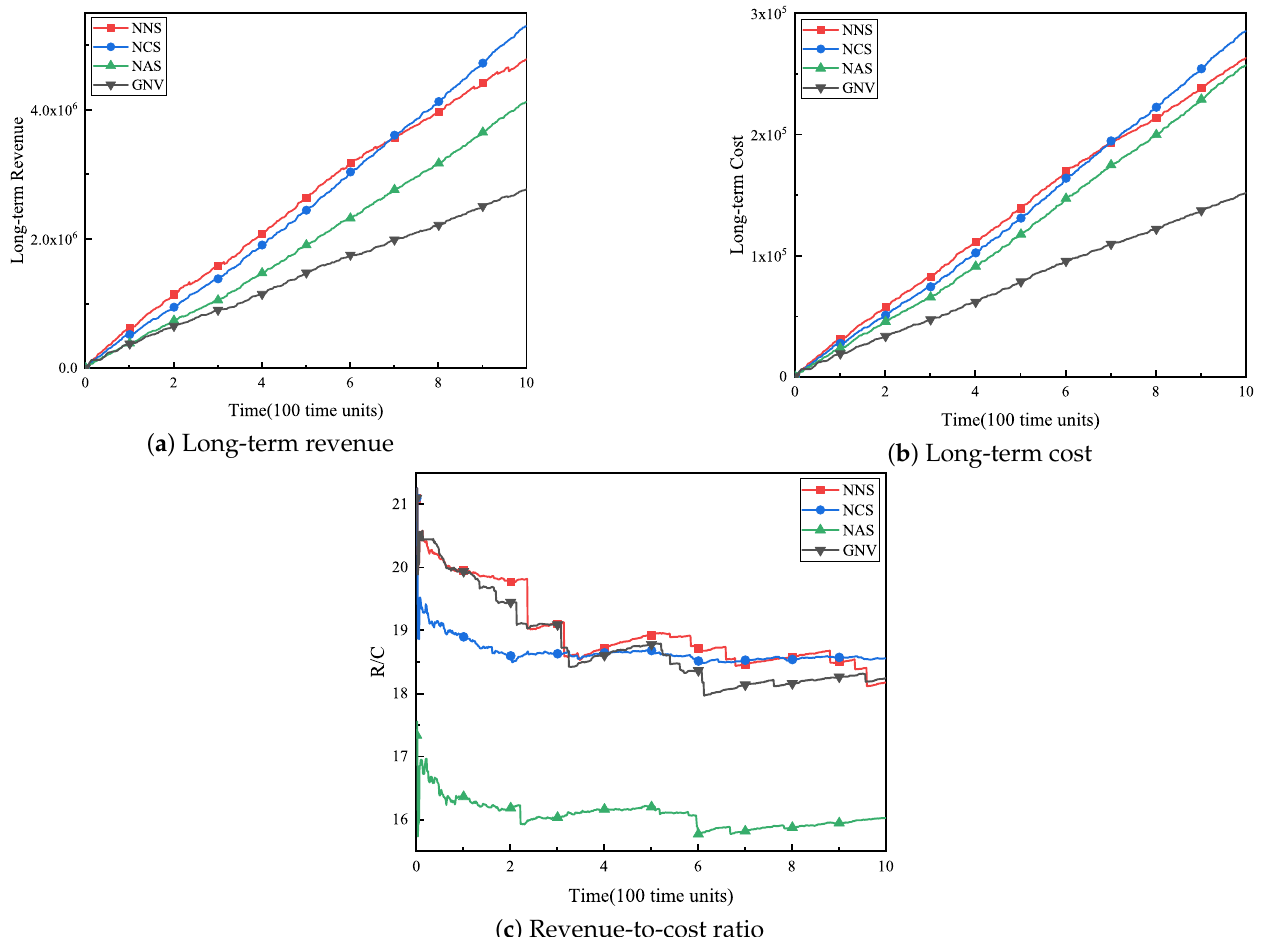
Figure 4. Wireless sensor network infrastructure provider (WSNInP) long-term operating